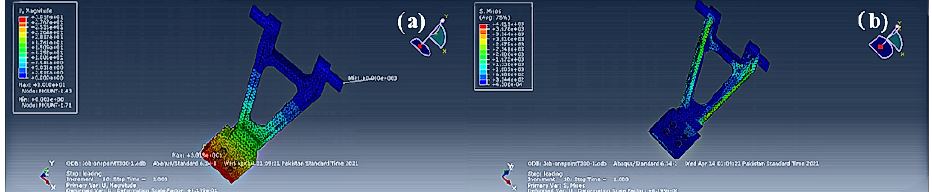
Figure 12. Results of ( a ) deformation and ( b ) von mises stresses on metallic mount of landing gear assembly under one point landing load condition.